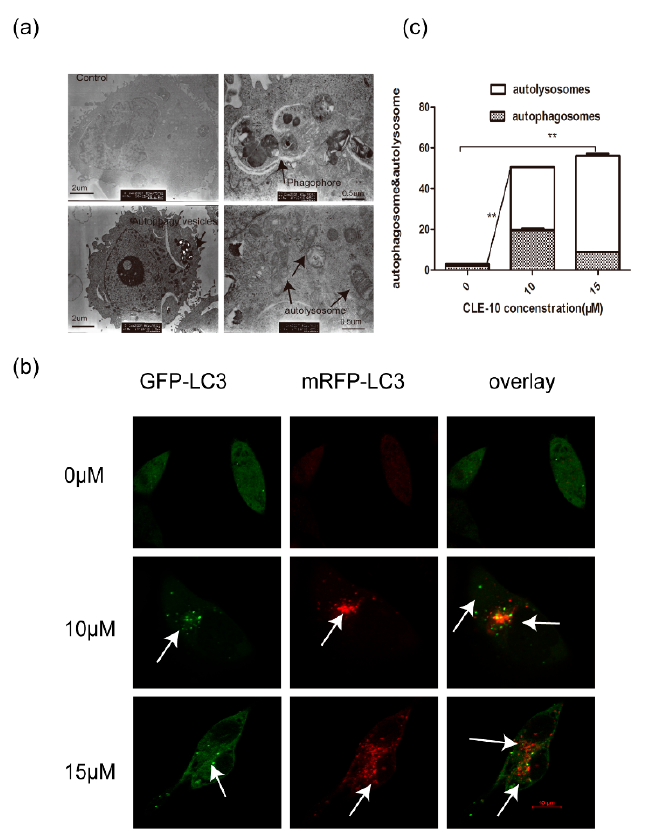
Figure 5. CLE-10-induced MDA-MB-231 cell death was mediated by autophagy. ( a ) Autophagy vesicles, autophagosomes, and autophagy lysosomes were observed in MDA-MB-231 cells after treatment with CLE-10. ( b ) MDA-MB-231 cells transfected with mRFP-GFP-LC3 adenovirus were detected with a confocal fluorescence microscopy. ( c ) The number of autophagosomes (yellow dots) and autolysosomes (red-only dots) in the control group and the CLE-10 group (** p < 0.01).